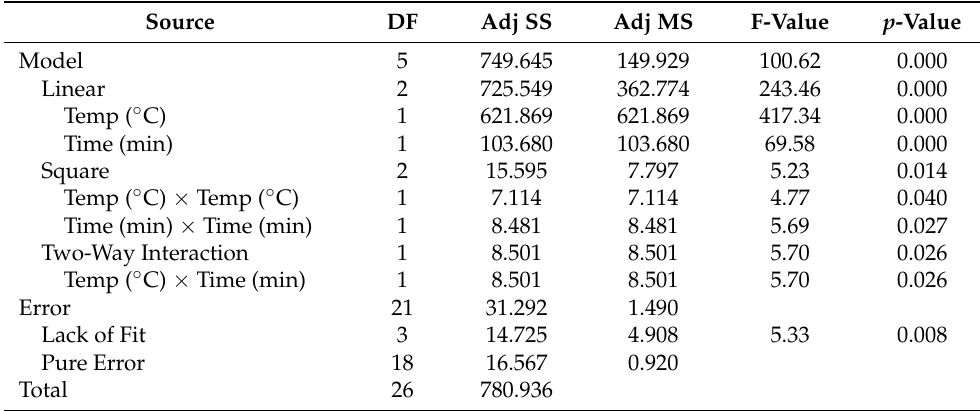
Table 6. Analysis of variance for lignin content.